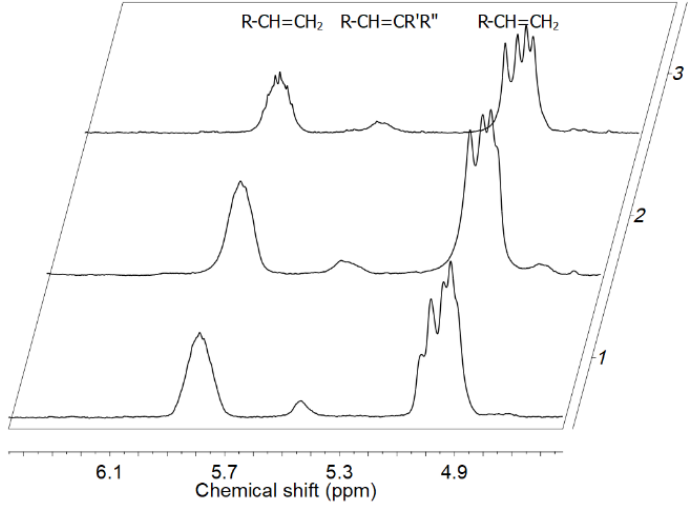
Figure 10. Unsaturation region in 1 H NMR spectra of E/POSS-10-3 copolymers for various contents of POSS: 1.65 wt % (1), 1.94 wt % (2), 3.25 wt % (3).